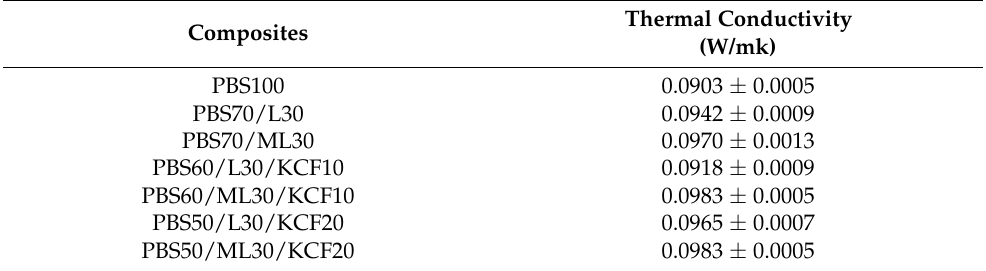
Table 3. Thermal conductivity and its composites.